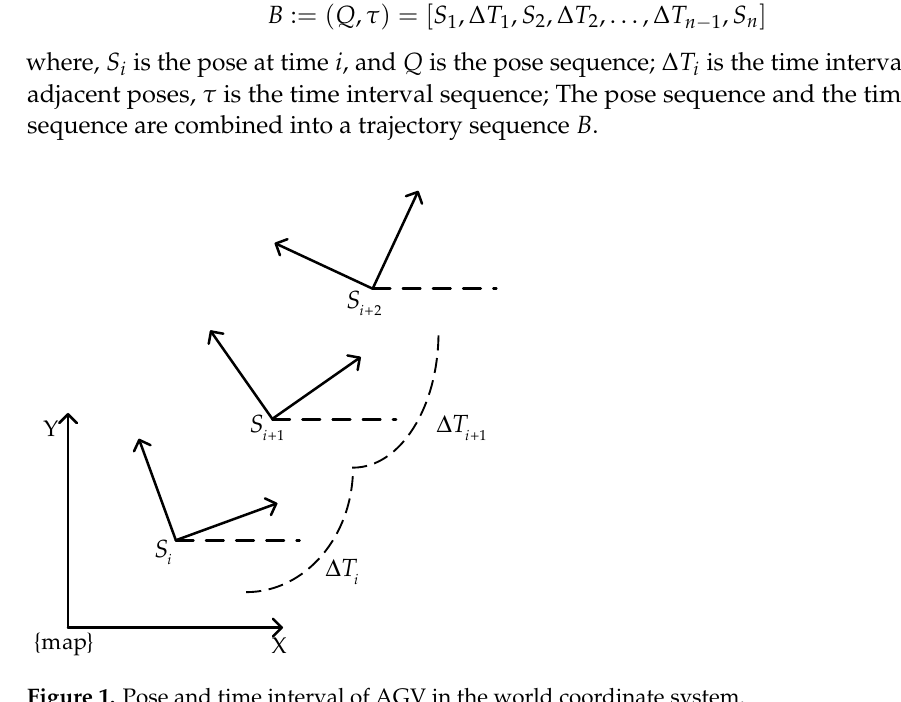
Figure 1. Pose and time interval of AGV in the world coordinate system.